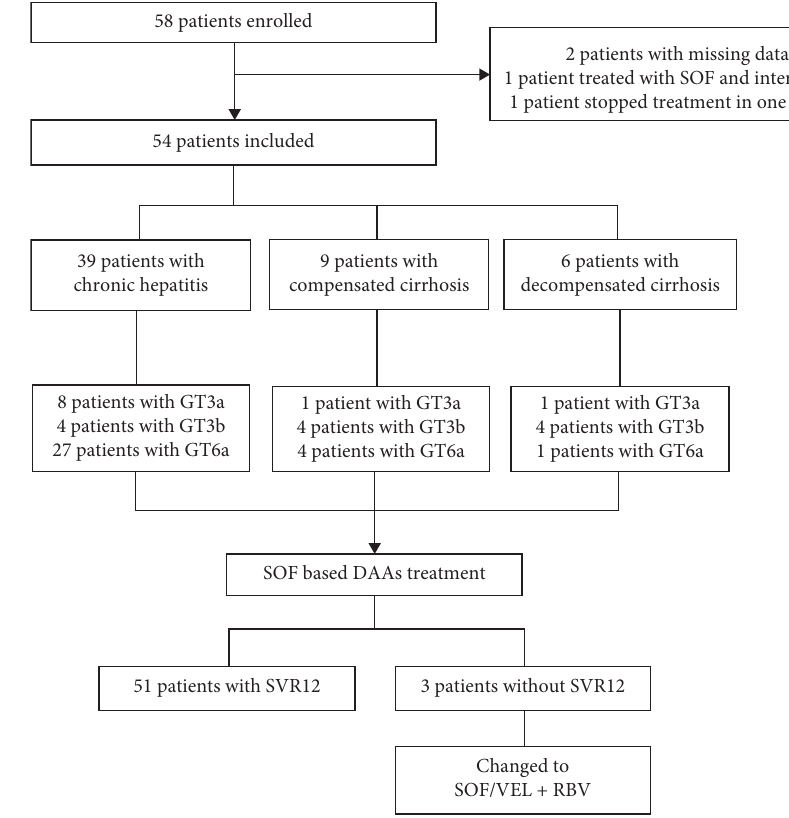
Figure 1: The CONSORT diagram of patient enrollment. Table 1: Demographic information and baseline